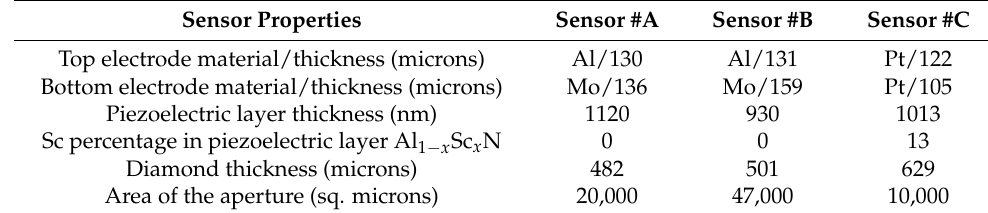
Table 1. Properties of HBARs in utilized sensors.